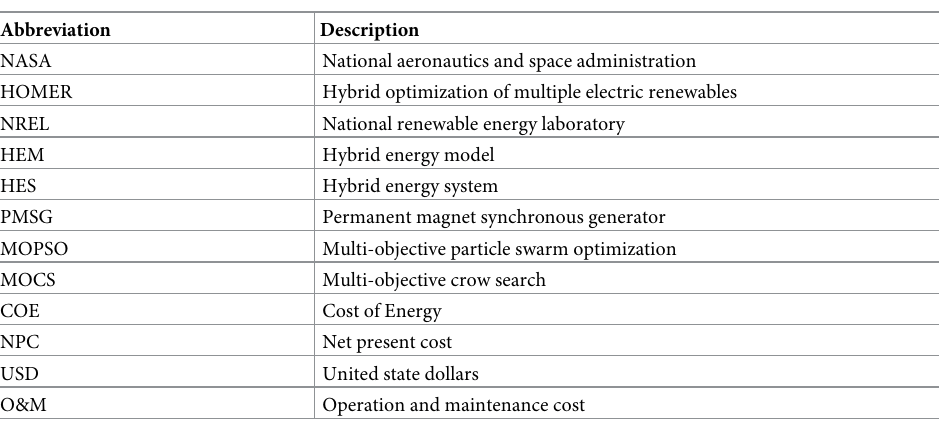
Table 1. List of abbreviations.